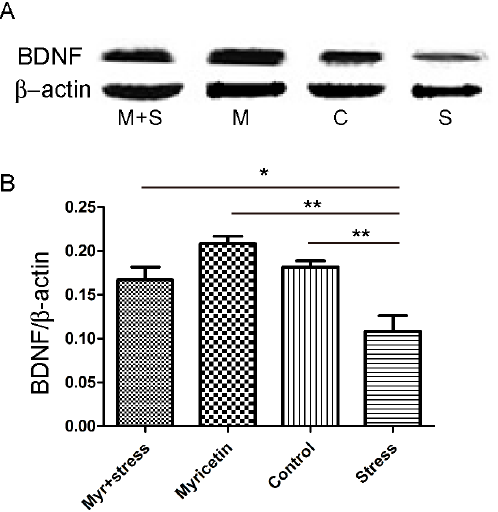
Figure 3. Effects of myricetin on the activities of glutathione peroxidase (GSH-PX) and superoxide dismutase (SOD) in the hippocampus of mice subjected to repeated restraint stress for 21 consecutive days. ( A ) Myricetin treatment reversed the decrease in the GSH-PX activity of the mice subjected to repeated restraint. Regular two-way ANOVA, significant treatment variation F (1,23) = 12.21, p < 0.01, Boferroni post-test, * p < 0.05 significant difference between groups; and ( B ) the SOD activity in hippocampus of mice subjected to stress exhibited a tendency of decrease, as compared to the control group, however, was not significant.